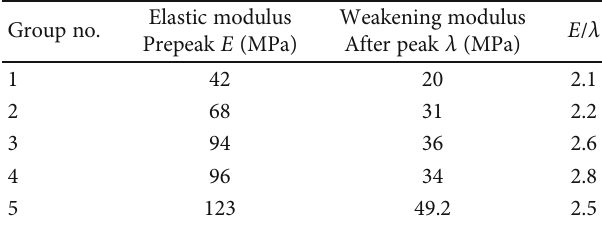
Table 4: Test results of brittleness characteristics of some similar